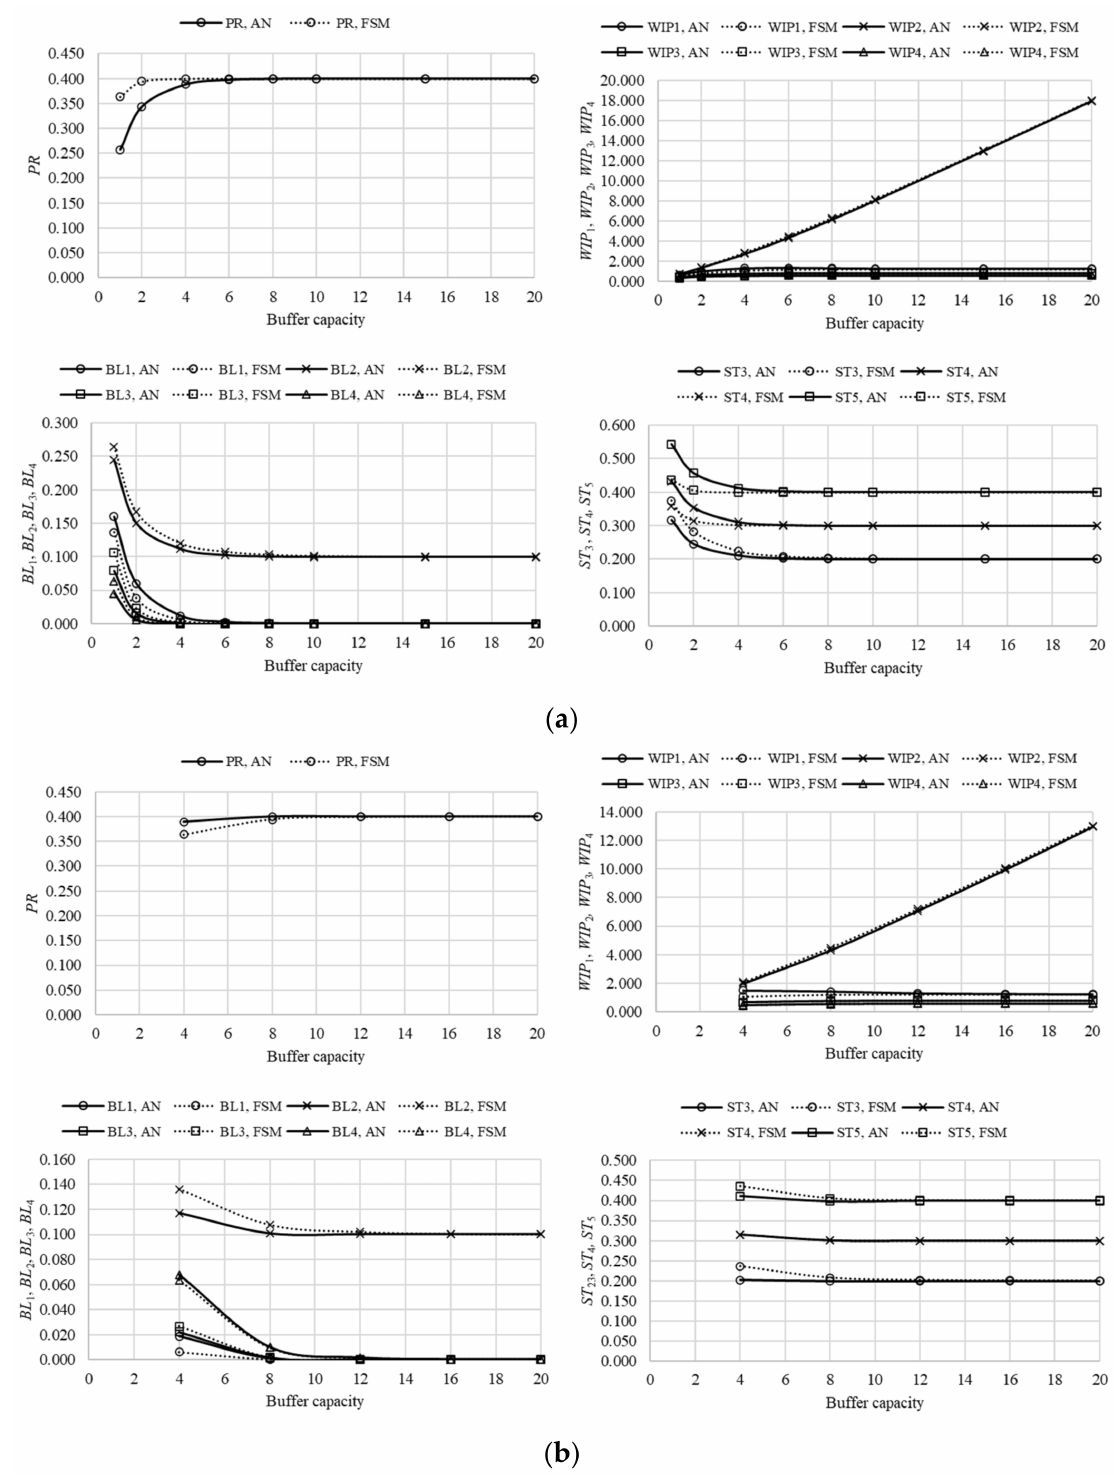
Figure 12. Comparison of the performance measures in the case of line L5D: ( a ) N 1 = N 2 = N 3 = N 4 = N